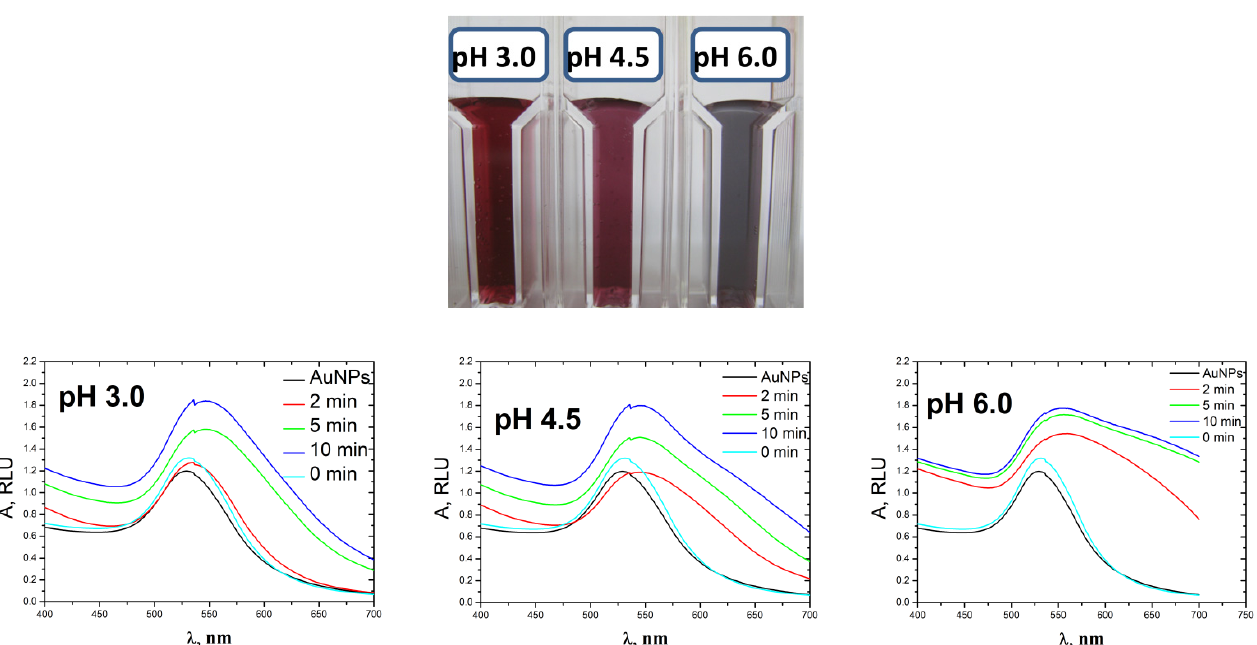
Figure 3. Spectra of streptavidin-AuNP conjugate during the reduction of HAuCl 4 with NH 2 OH at different pH and reaction time. The black lines correspond to the spectra of colloidal solutions without amplification.